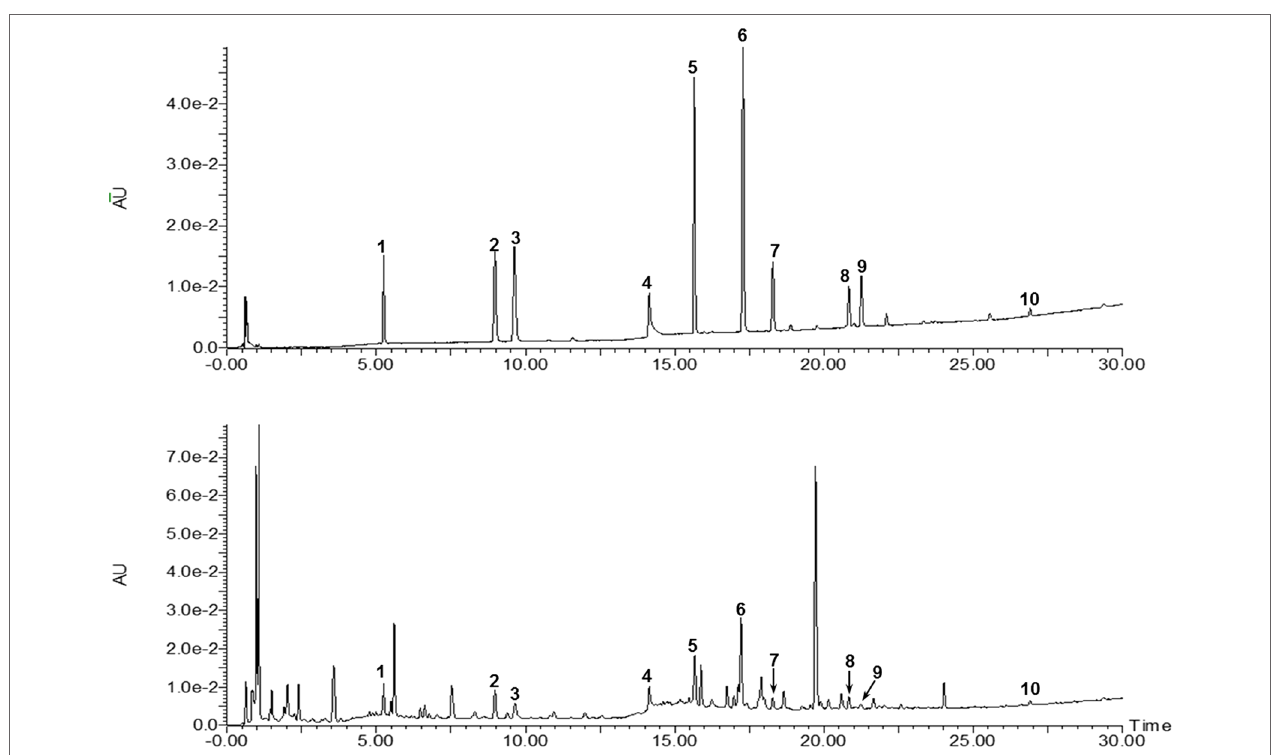
FIGURE 3 | Ultraperformance liquid chromatography-photodiode array (UPLC-PDA) chromatograms of the mixed standards and HT. 1 : Danshensu, 2 : 3-caffeoylquinic acid, 3 : caffeic acid, 4 : paeoniflorin, 5 : rutin, 6 : quecertrin, 7 : rosmarinic acid, 8 : salvigenin, 9 : calycosin, and 10 : glyrrhizic acid.